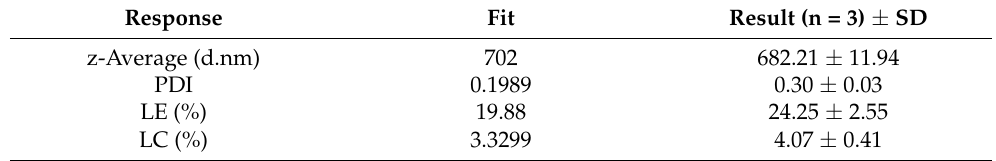
Table 4. Prognosis for optimised parameters of screening and results of the control samples.